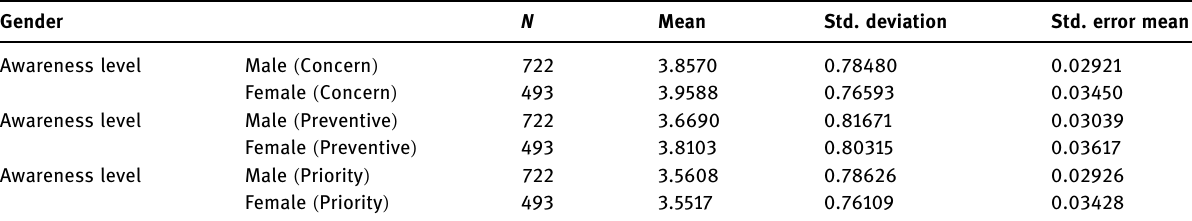
Awareness level Male ( Priority